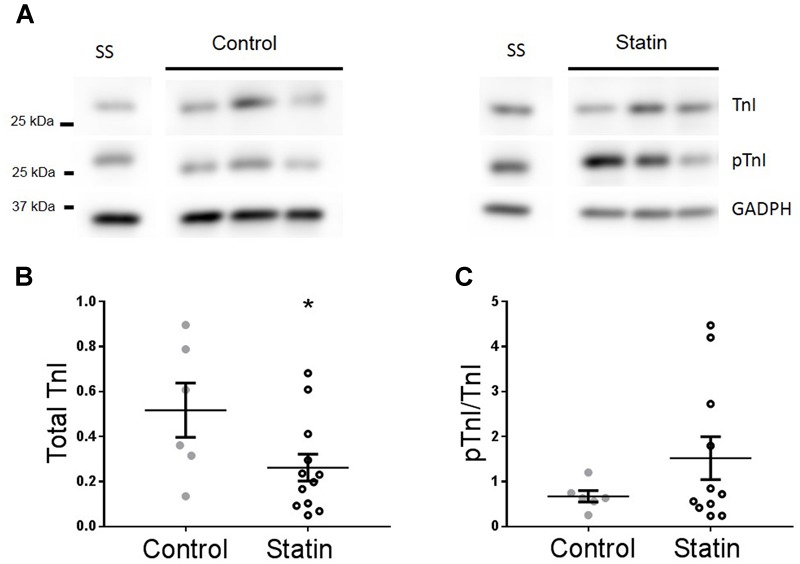
Effect of statin treatment on TnI and Ser23/24 phosphorylated TnI (pTnI) in human myocardium. Representative immunoblots (A) and scatter plots showing expression of total TnI normalized to GAPDH (B) and pTnI normalized to total TnI (C) in atrial muscle from statin-treated male patients (N = 14). Patients not taking statins formed the control group (N = 6). SS = standard sample to allow inter-gel comparisons (see Materials and Methods, Western blotting). Plots show mean ± SEM. ∗P < 0.05 vs. control group (Student’s t-test).